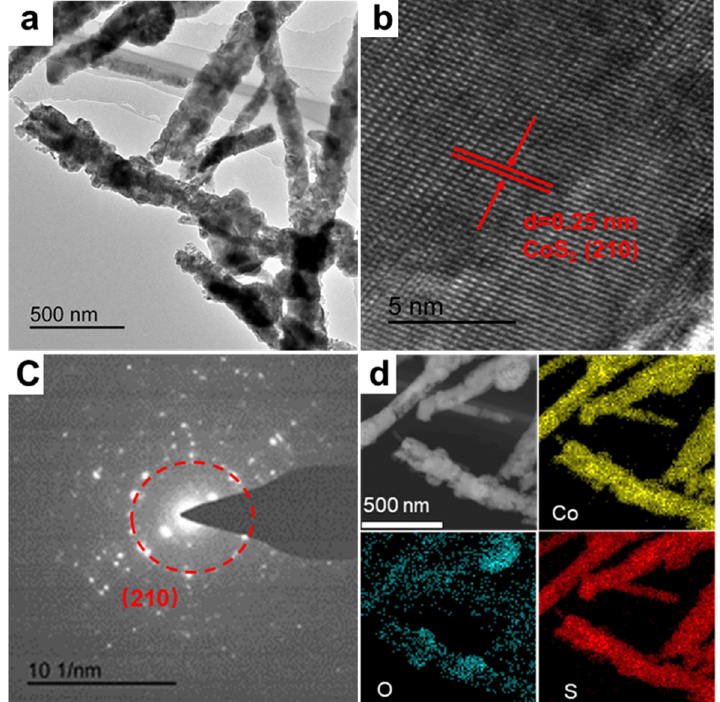
Figure 3. ( a ) A TEM image of the CoS 2 NWs; ( b ) a high-resolution TEM image; ( c ) the diffraction rings; ( d ) and an elemental distribution map (EDX).